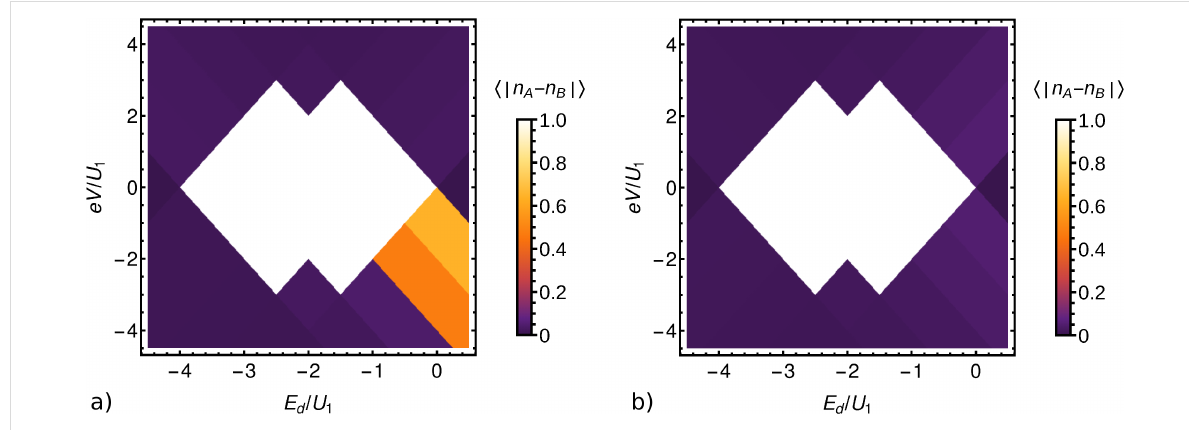
Figure 6: Average imbalance between the occupations n A and n B of the two checkerboard sublattices for a) asymmetric tunneling, Γ top / Γ bottom = 0.5, and b) symmetric tunneling, Γ top / Γ bottom = 1 [15], both for a degeneracy of 2 of occupied single-site states.